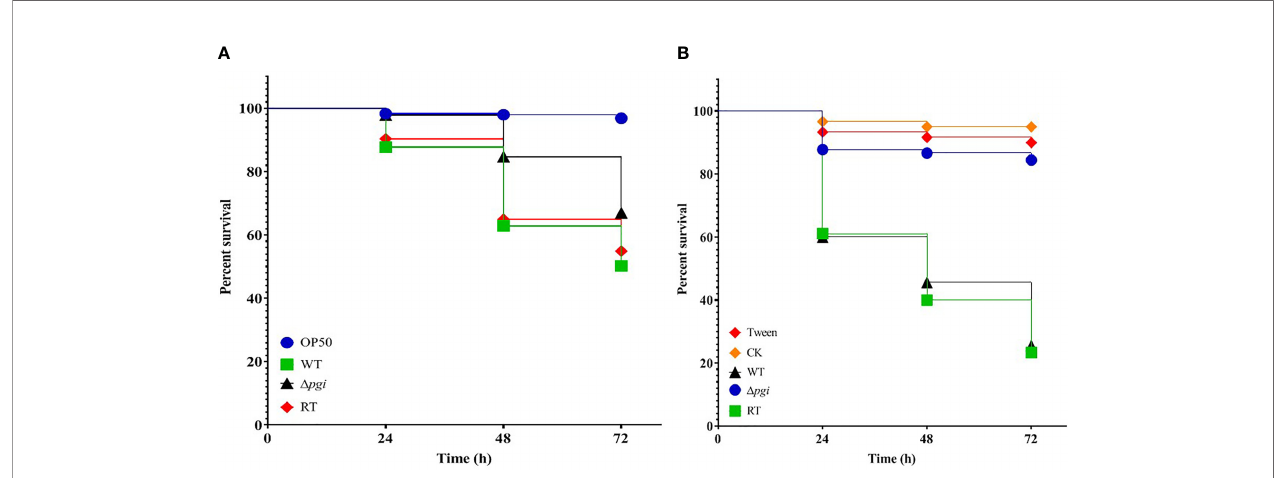
FIGURE 7 | Virulence of the mutant in animal models. (A) Kaplan – Meier curve of the survival rate of glp-4(bn2); sek-1(km4) worms at 24, 48, and 72 h after being pre-infected with conidia for 16 h. E. coli OP50 was used as a positive control. Three biological repeats with triplicate setups were performed for each strain. (B) Kaplan – Meier curve of the survival rate of G. mellonella larvae at 24, 48, and 72 h after infection with conidia. Three biological repeats with triplicate setups were performed for each